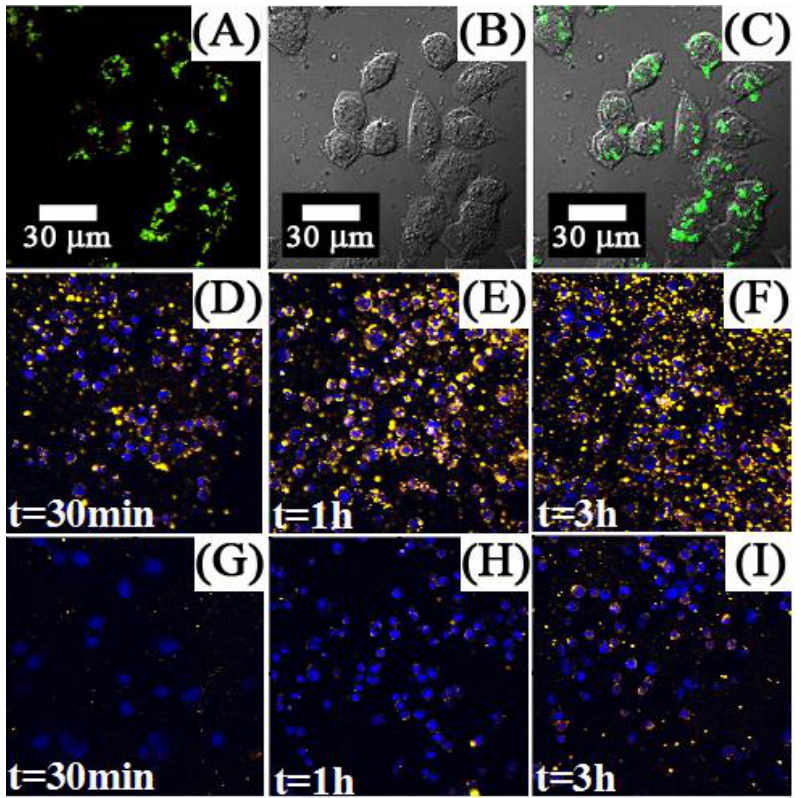
Figure 12. First row: luminescence ( A ), bright-field ( B ) and overlap of both images ( C ), of KB cells cultured with UCNPs-Ad/β-CD ([123], reproduced by permission of the Royal Society of Chemistry). Second and third rows: Fluorescence imaging of MB49 cells cultured with: carbonized glucose-coated UCNPs ( D ), ( E ) and ( F ); silica-coated UCNPs ( G ), ( H ) and ( I ) ([120], reproduced by permission of the Institute of Physics).